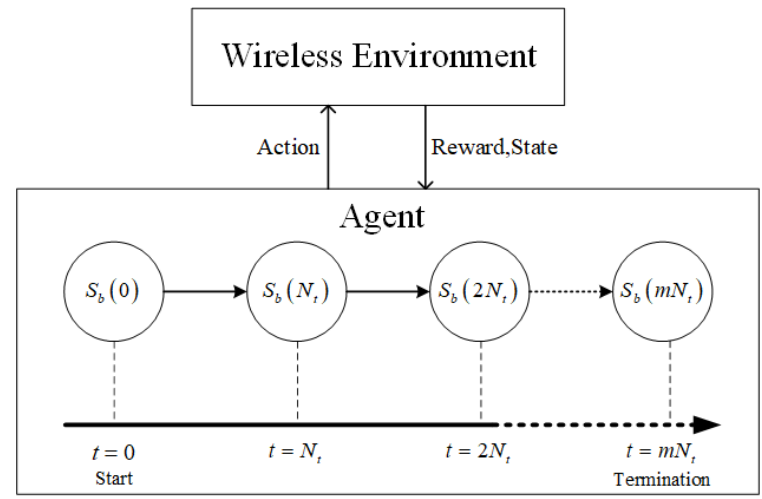
Figure 2. State transition